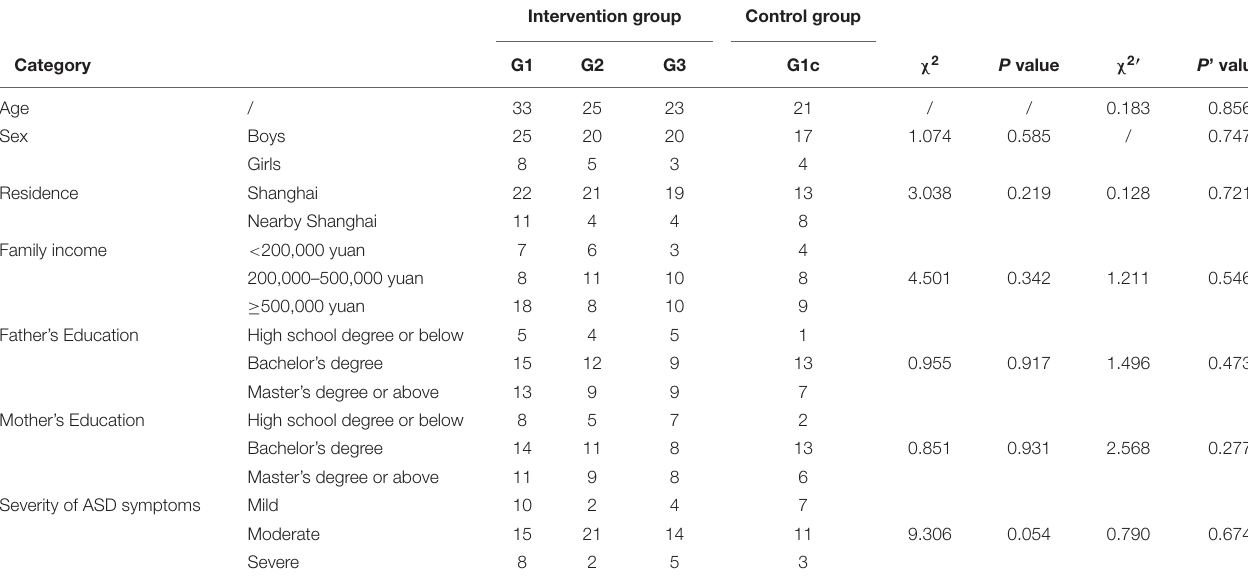
TABLE 1 | Demographic characteristics of the intervention and control groups.